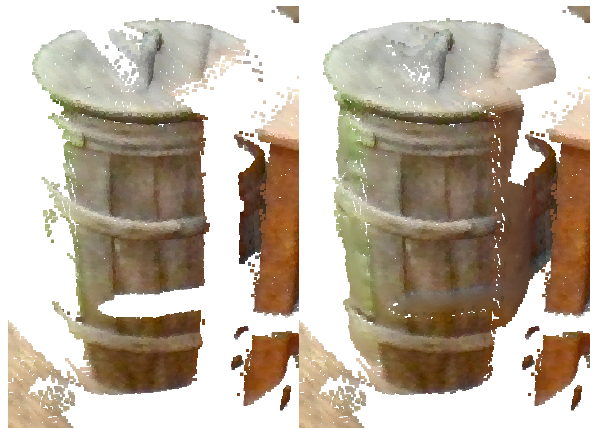
Figure 6. A close-up view of input (left) and output (right) point cloud of a wooden barrel in the Backyard segment. Note how both the shape and colors of the generated surfaces match the surrounding scan.